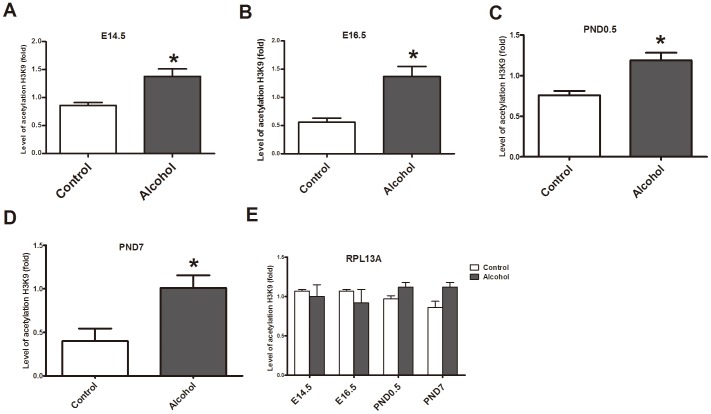
Hyperacetylation of histone H3K9 induced by alcohol on the Gata4 promoter.ChIP-Q-PCR results (A,B,C,D) showed that alcohol is linked to histone H3K9 hyperacetylation on the Gata4 promoter at E14.5, E16.5, PND0.5 and PND7, respectively. However, alcohol could not affect acetylation of H3K9 on the promoter of RPL13A (E). *: P<0.05 vs. control group (n = 3). E14.5: embryo 14.5 day, E16.5: embryo 16.5 day, PND0.5: postnatal day 0.5, PND7: postnatal day 7.